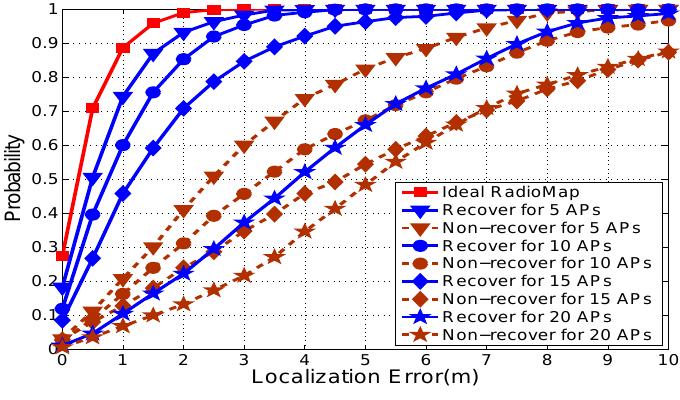
Figure 13. Localization error comparisons for 5, 10, 15 and 20 access points randomly